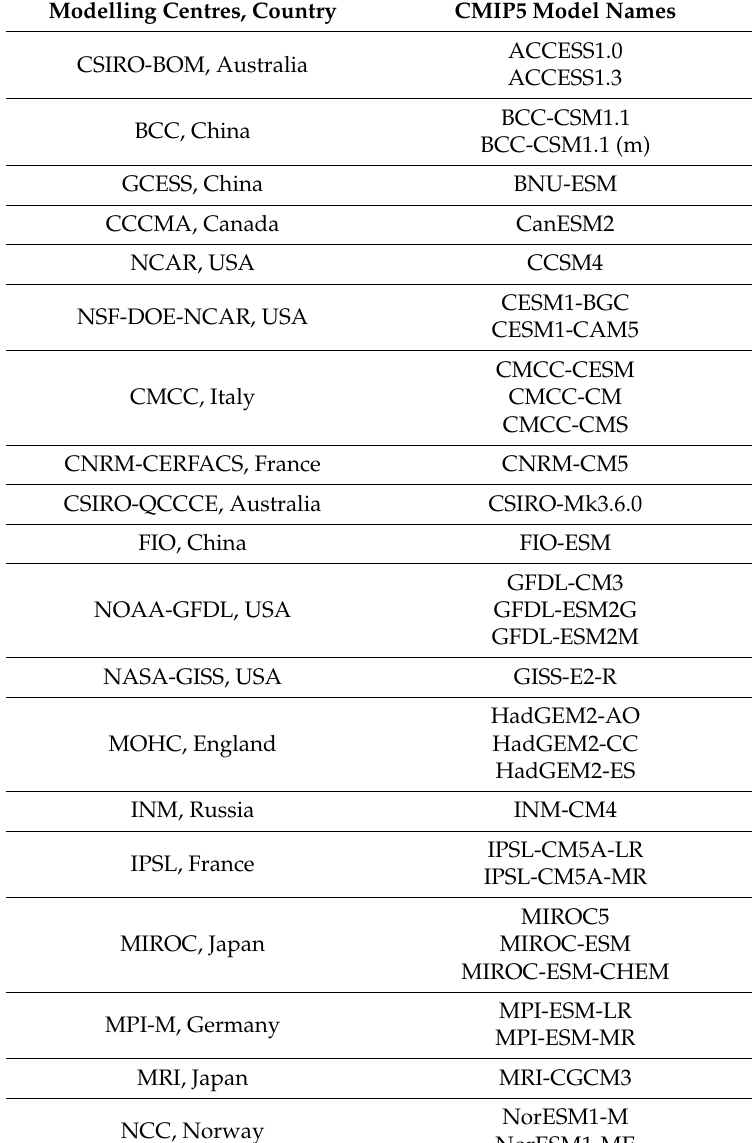
Table 1. CMIP5 models used in this analysis with the name of the modelling centres and respective